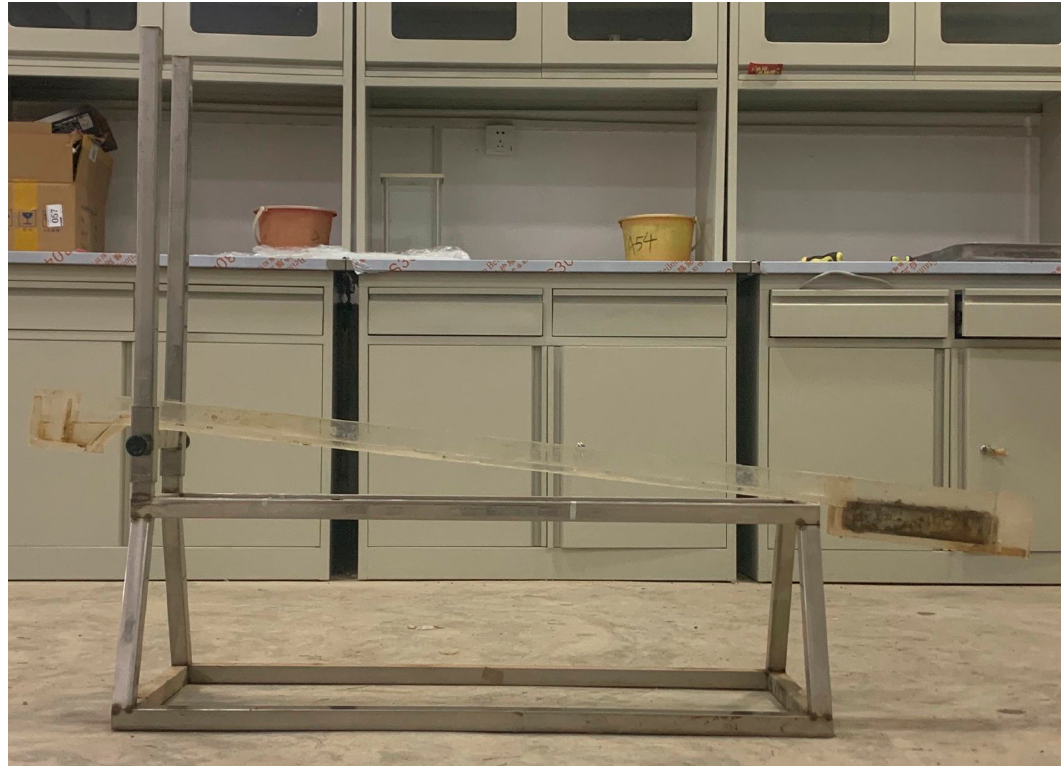
Figure 2. Side view of the experimental setup for the flume apparatus used to measure soil detach- ment.